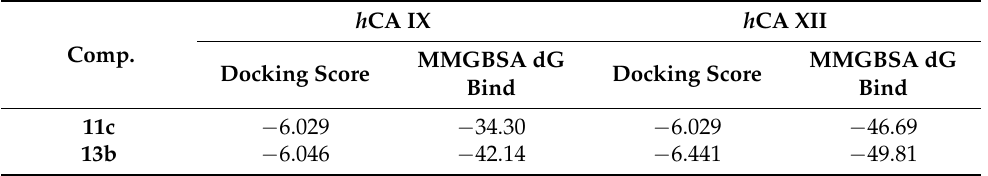
Table 6. The docking scores and binding energy from MMGBSA for QBS 11c and 13b on h CA IX and XII.